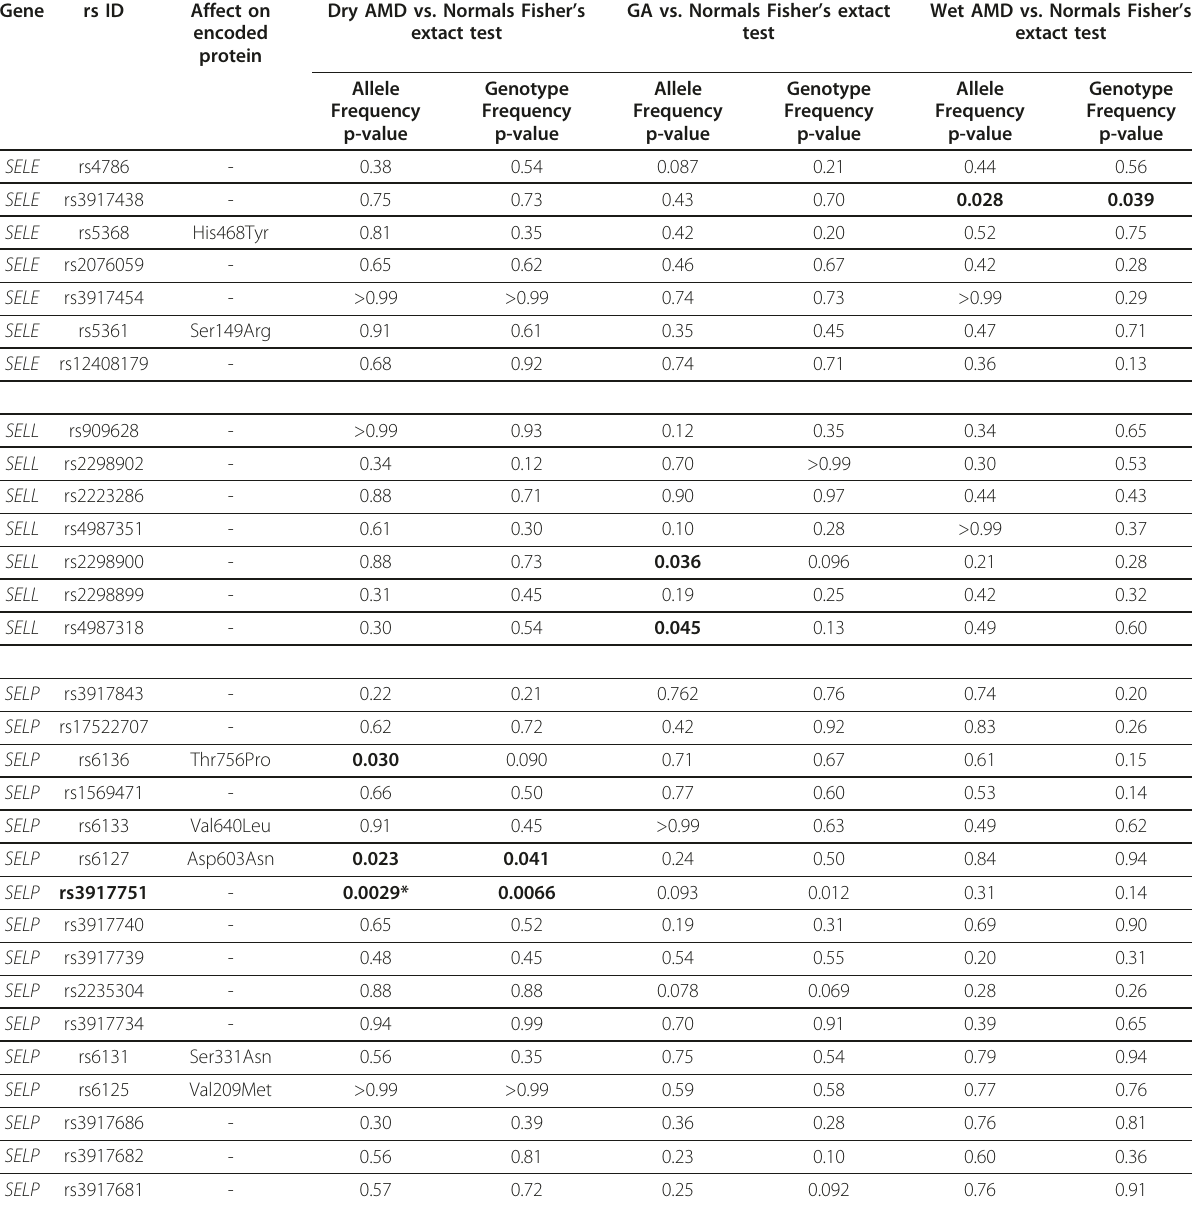
Table 2 Sub-group analysis of SNPs in SELE , SELL and SELP Gene rs ID Affect on encoded